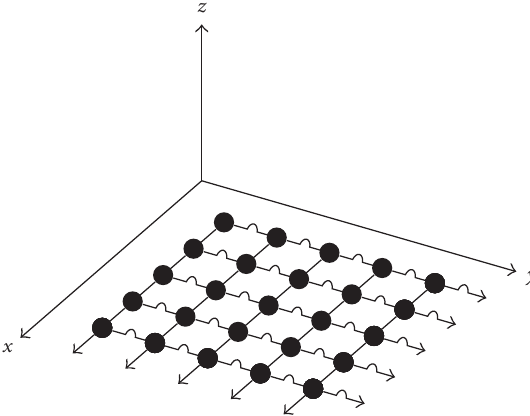
Figure4:Representationofthemembraneasasuccessionofmasses and springs, each mass joined to its neighbors as north, south, east, and